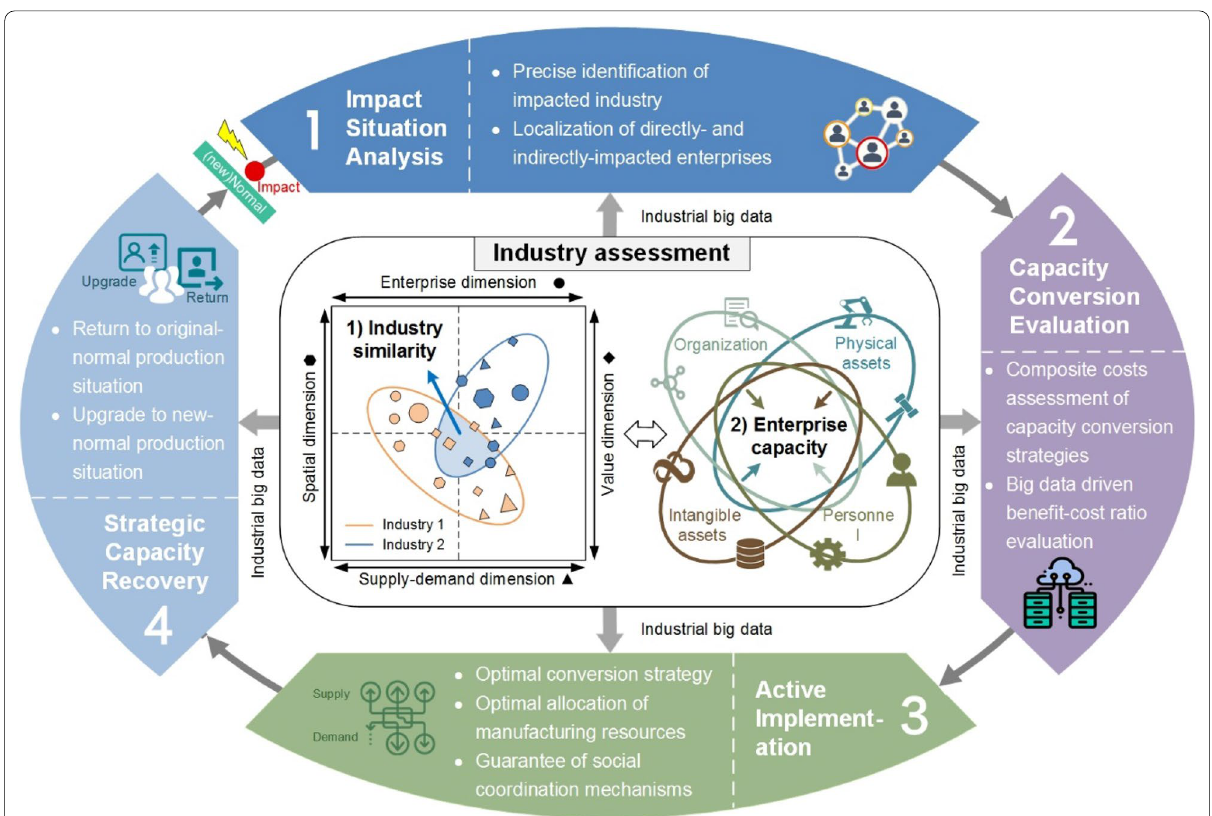
Figure 1 A conceptual framework for resilient manufacturing